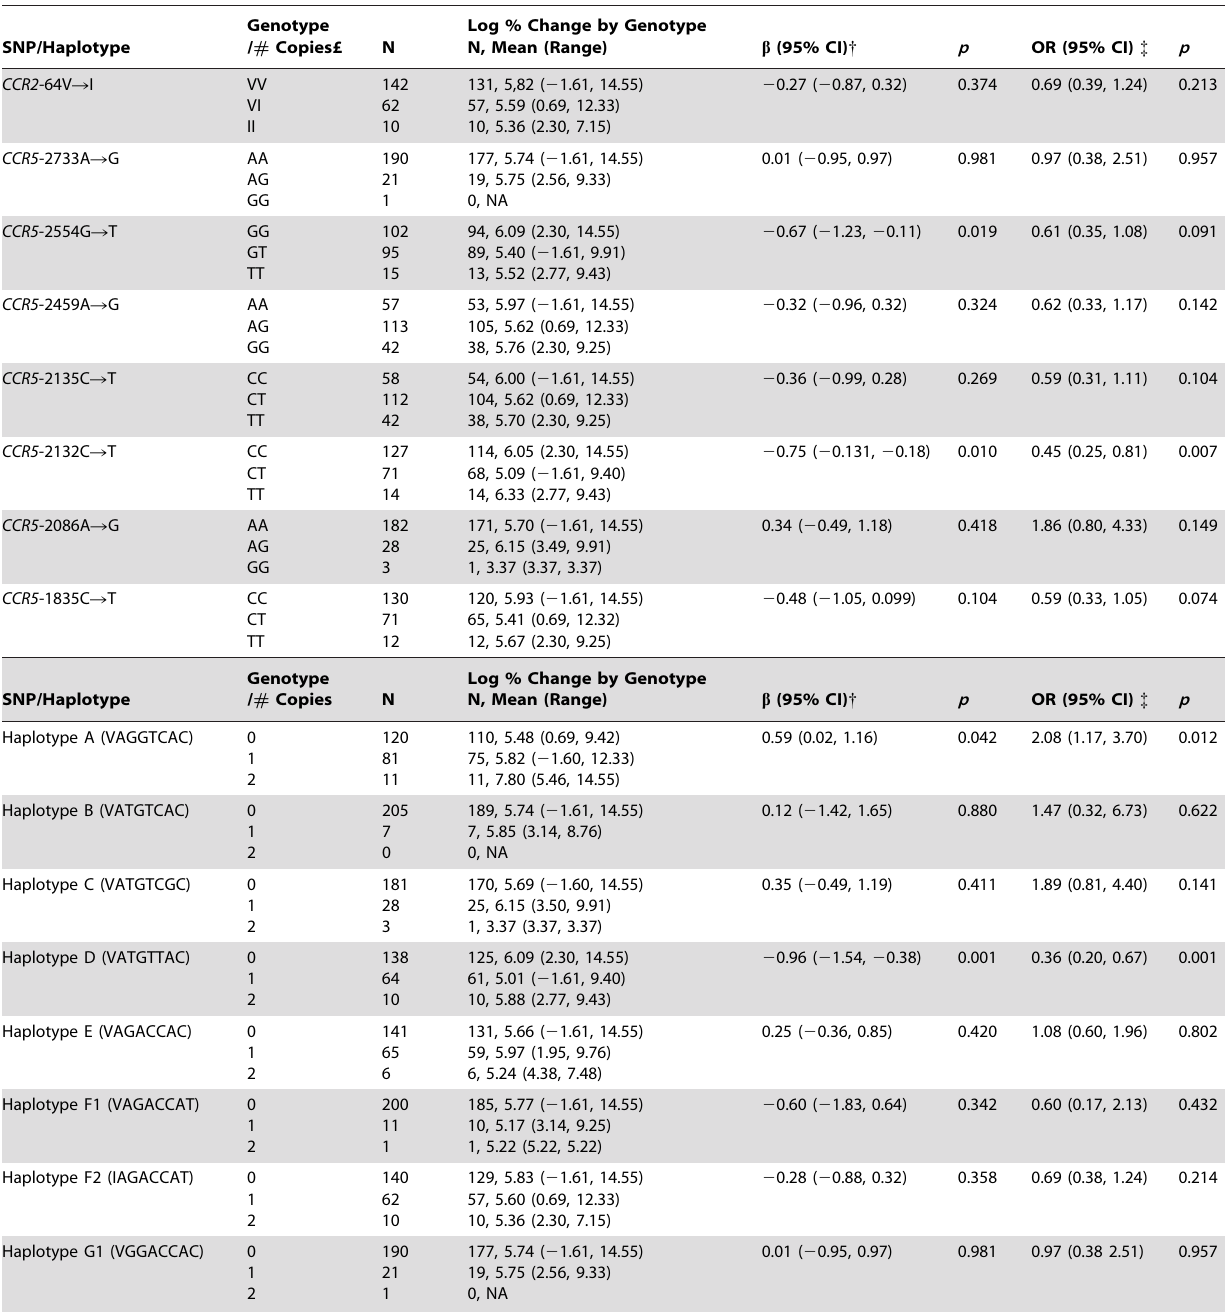
{ Linear regression for the association between CCR5 expression and CCR5 SNP/haplotype: Continuous outcome of placental expression. b : Beta coefficient, 95% CI: 95% Confidence Interval for the Beta, p : p -value. { Logistic regression for the association between CCR5 expression and CCR5 SNP/haplotype: Dichotomous outcome of high vs. low placental expression of CCR5 dichotomized at the median value. OR: Odds Ratio, 95% CI: 95% Confidence Interval for the Odds Ratio. £ # Copies: Number of copies of haplotype: 0, 1, or 2 copies possible per subject. SNPs and haplotypes categorized as having one or more copies of the variant allele or haplotype compared to zero